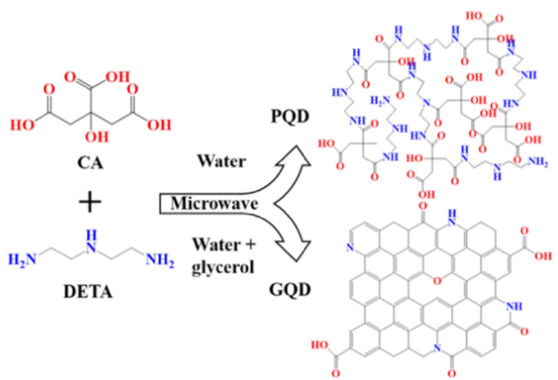
Quantum dots are 0-D nanomaterials of a few nanometers with different properties from larger particles due to quantum mechanics. Shi et al. investigated the effect of adding polymer-like quantum dots (PQD) and graphitic-like QDs (GQD) to a PEBAX matrix on gas separation performance (Figure 12). They found that, while PQD destroyed the crystalline structures of the polymer matrix, GQD with fewer functional groups caused an enhancement in microphase separation of PEBAX with only 0.05 wt.% loading, which led to more segregated domains for selective CO 2 permeation. As a result, only 0.05 wt.% of GQD loading is needed to achieve an optimal gas separation property, while 1 wt.% is needed for PQD [187].